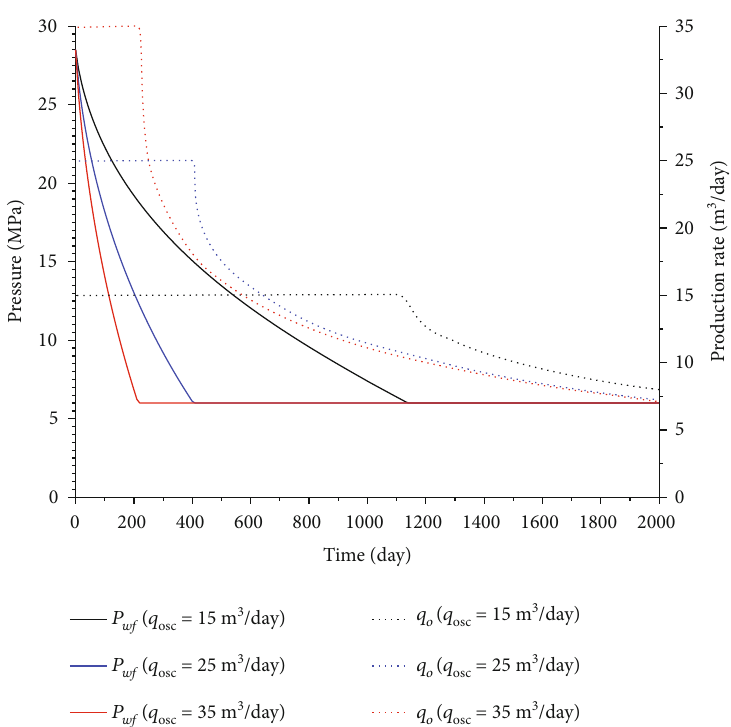
Figure 16: E ff ect of initial fl ow rate on the performance curve (compound working system).